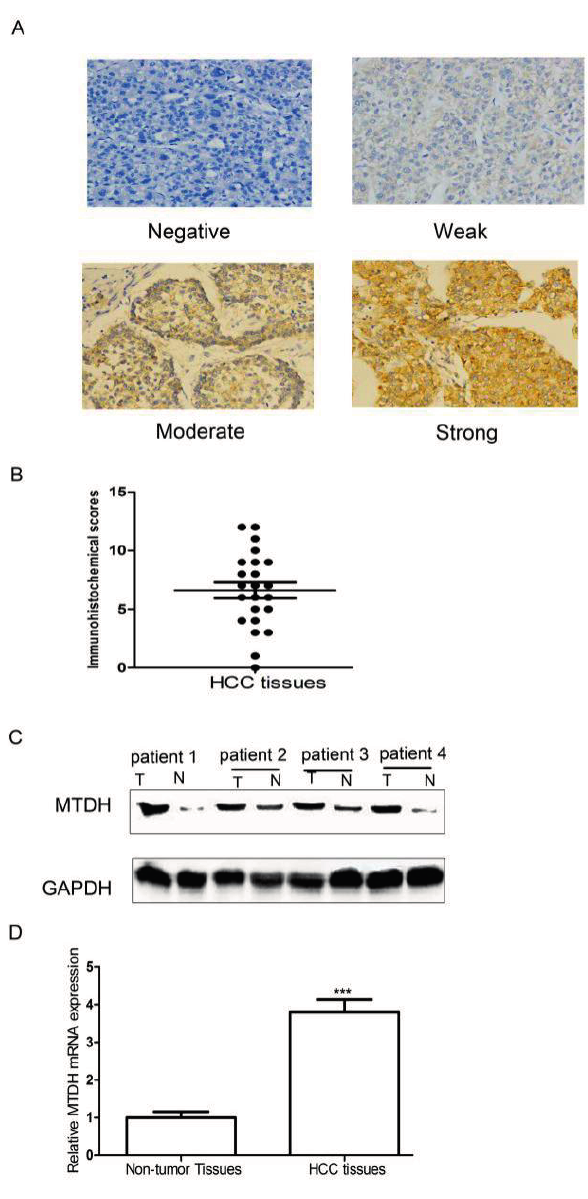
Figure 1. Expression situation of MTDH. ( A ) Representative MTDH microphotographs of immunohistochemistry (200×); ( B ) Representative immunohistochemical scores of MTDH in HCC tissues; ( C ) Western blot was used to compare MTDH protein expression in HCC tissues and matched noncancerous liver tissues. (T: tumor tissues and N: non-cancerous liver tissues); ( D ) q-PCR to test MTDH mRNA expression in HCC tissues and matched noncancerous liver tissues . *** p <